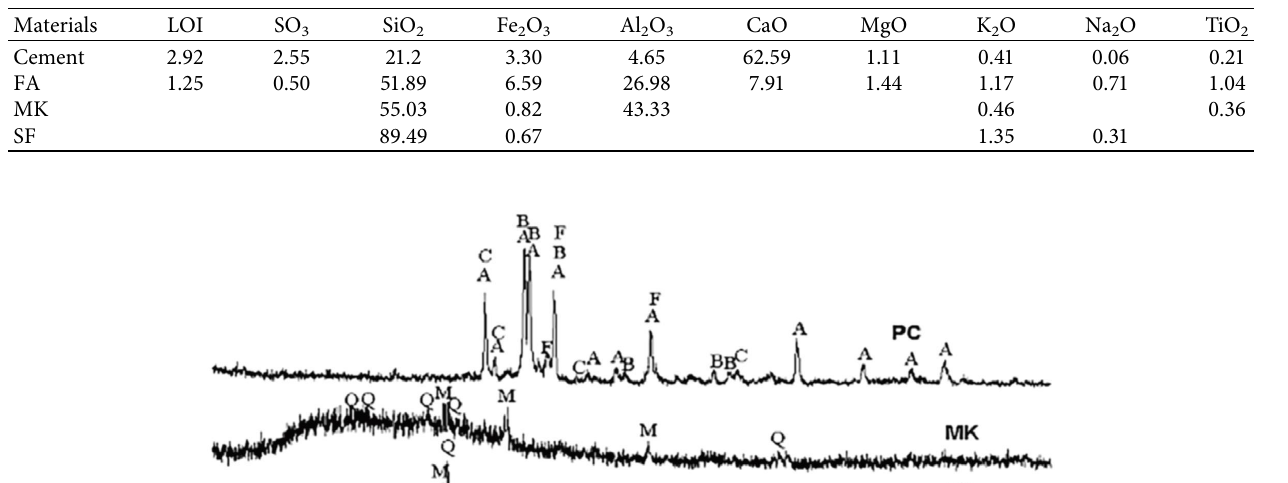
Table 2: Chemical compositions of raw materials.